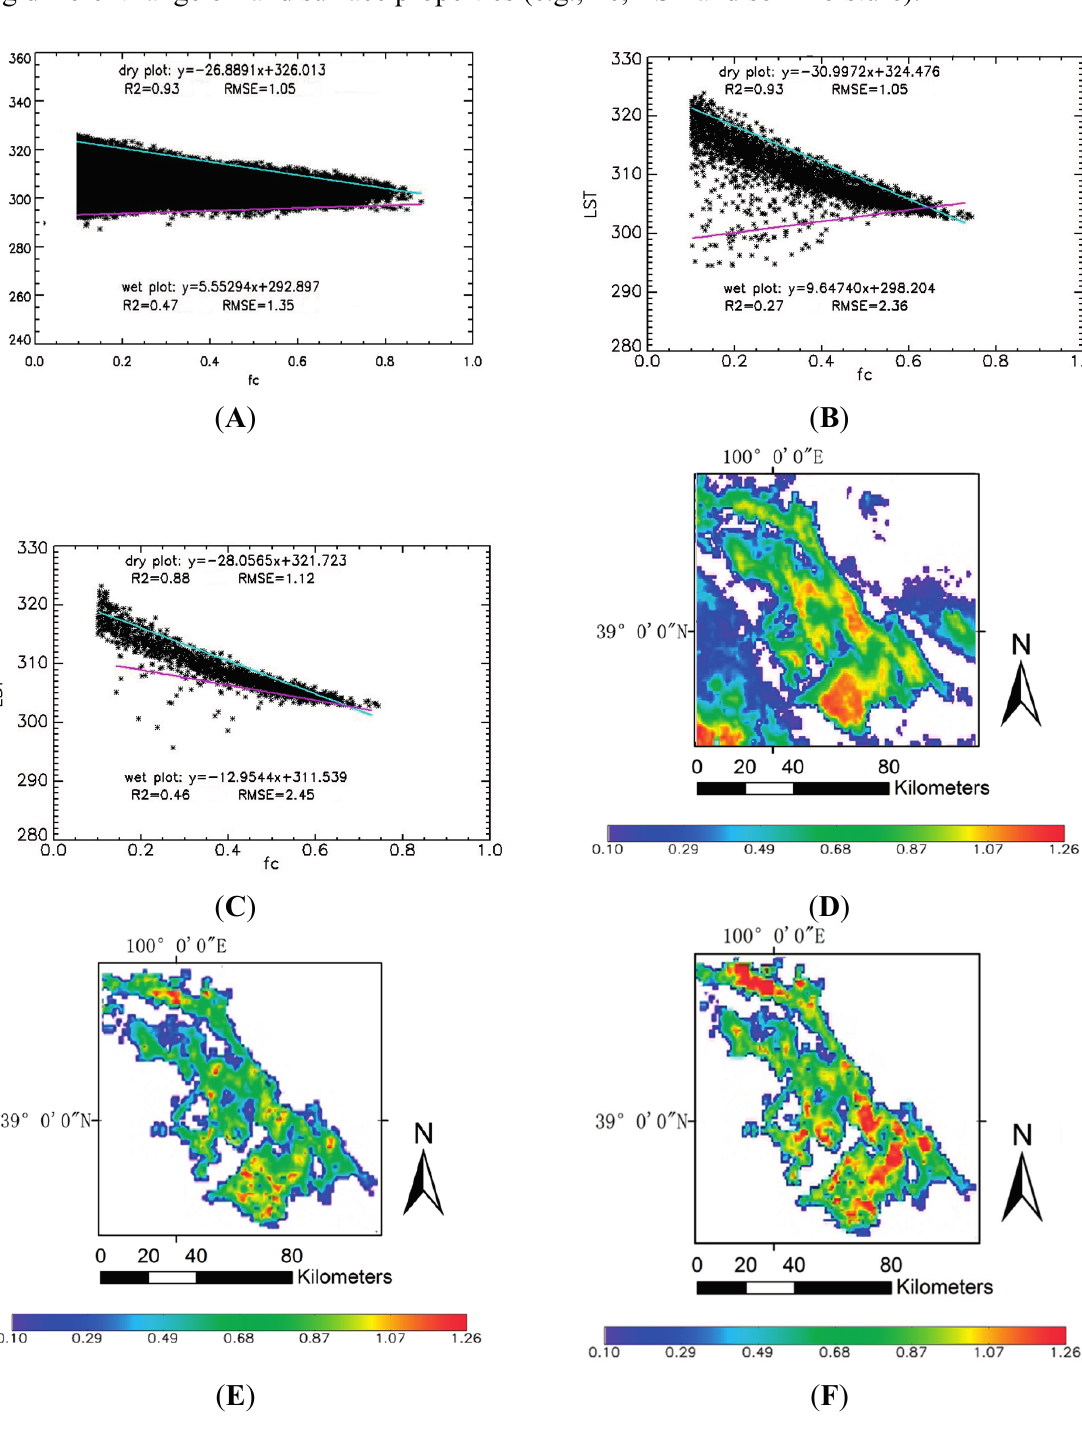
Figure 4. The LST-Fc feature space constructed respectively using: ( A ) image window A; ( B ) image window B; and ( C ) image window C in Figure 3; ( D , E , F )—the coefficient φ of the target area estimated using the three windows A, B and C in Figure 3 for LST-Fc feature space,